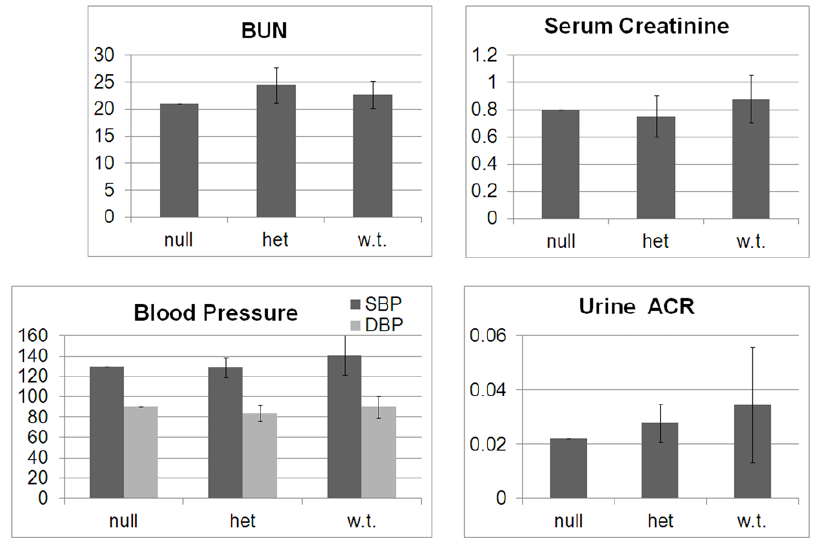
Figure 2. Clinical Data. From 51 subjects, clinical data for blood pressure, serum BUN, serum creatinine, and urine albumin:creatinine ratios were sorted by genotype for comparison: ‘‘null’’=homozygous null (N=1); ‘‘het’’=heterozygote (N=8); ‘‘w.t.’’=wild type (N=42). Error bars represent S.D.